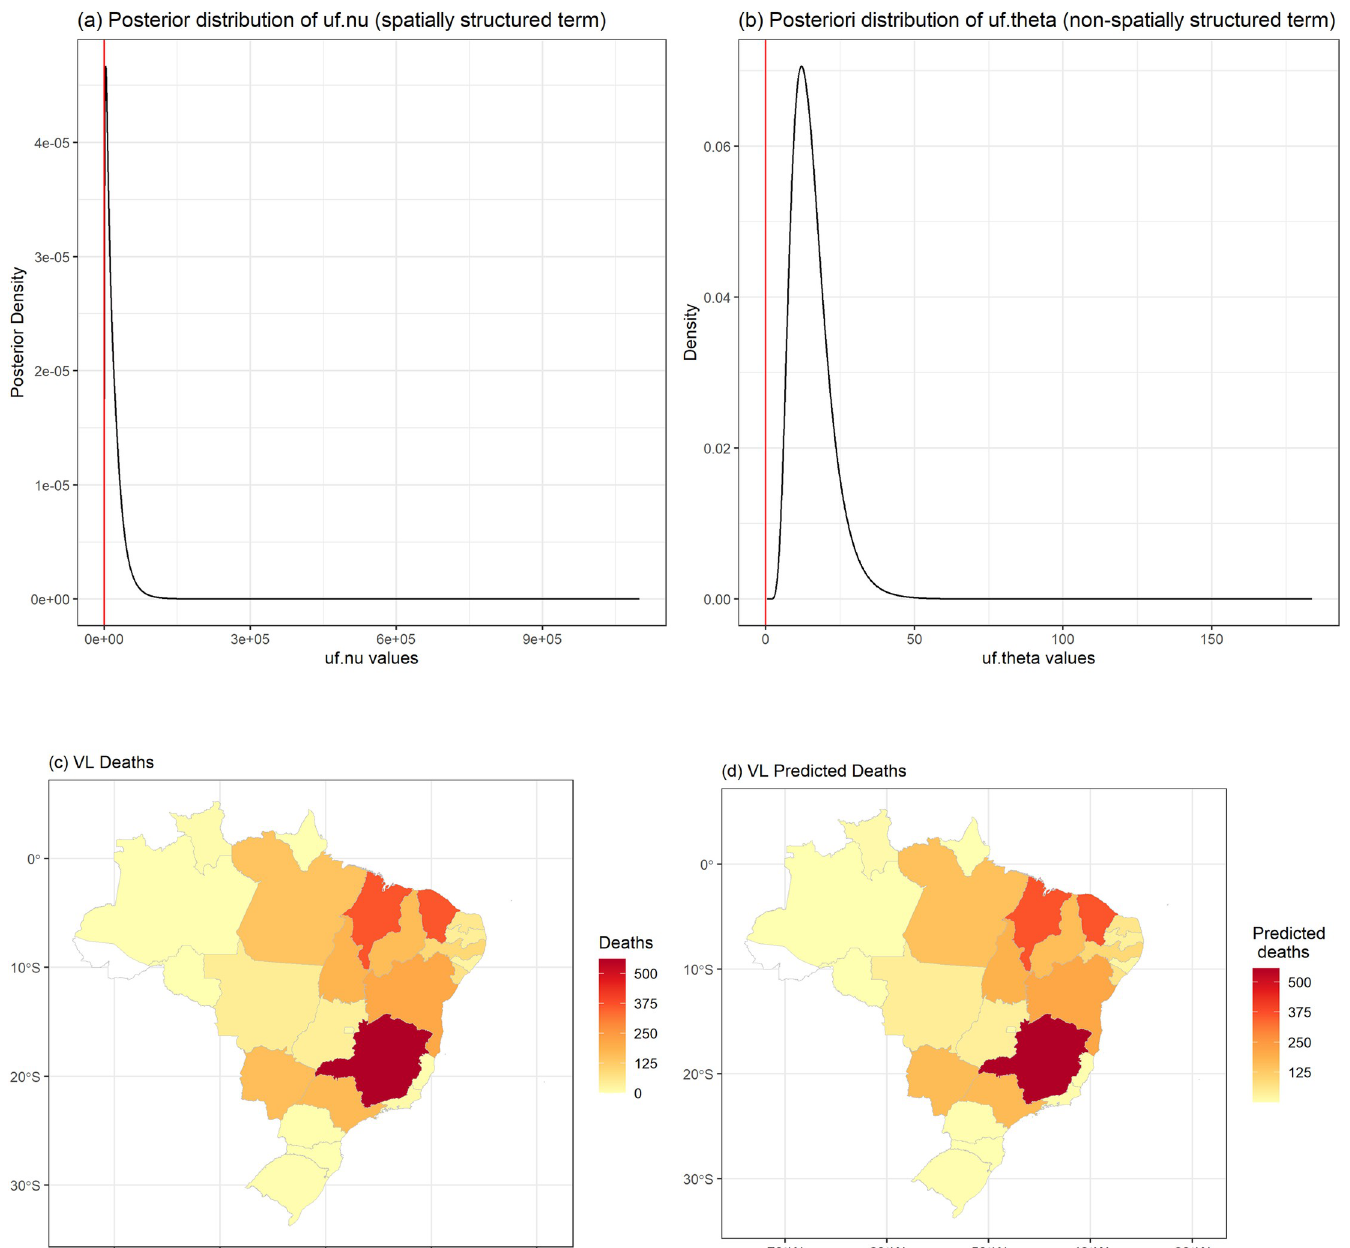
Fig 3. Posteriori distributions of the structured spatial term–uf.nu (a) and the unstructured spatial term—uf.theta (b) hyperparameters. Observed deaths (c) and predicted deaths (d) fitted by CAR model, Brazil, 2007–2017. The maps were built using the free and open source R software (https://www.R-project.org/.) based on shapefiles obtained from Instituto Brasileiro de Geografia e Estatı´stica-IBGE) (https://portaldemapas.ibge.gov.br/portal.php#homepage). https://doi.org/10.1371/journal.pntd.0009567.g003 cases (25% of missing data). After the exclusion of cases reported as death from other causes, VL cases with outcome defined as cure or death from VL totaled 31856 cases. In the 11-year study period, 2735 patients died from VL (case-fatality of 8.4%). From a clinical perspective, several differences were observed between fatal and non-fatal VL cases, significance defined by a p value of 0.05. The medians of age and the interval from